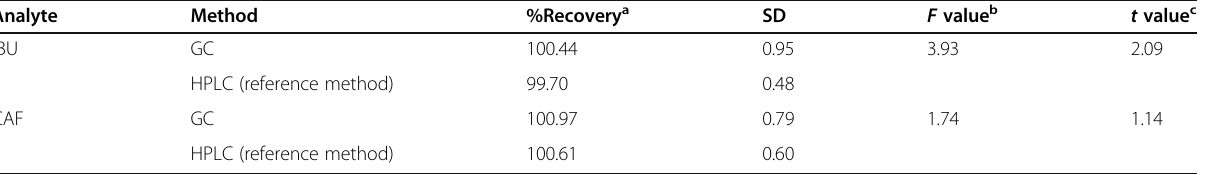
Table 6 Application of the proposed method in the analysis of IBU and CAF commercial tablet